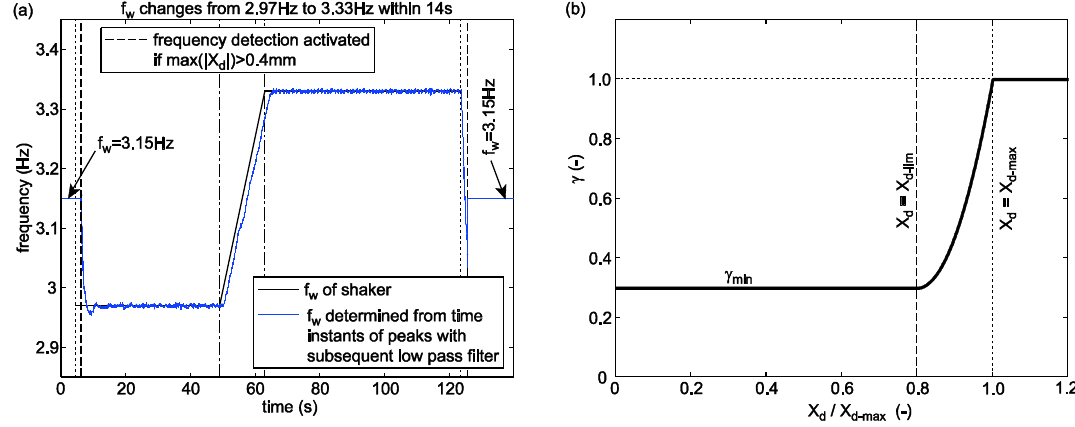
Figure 2. ( a ) Real-time frequency detection; ( b ) proposed design of adaptive damping gain.